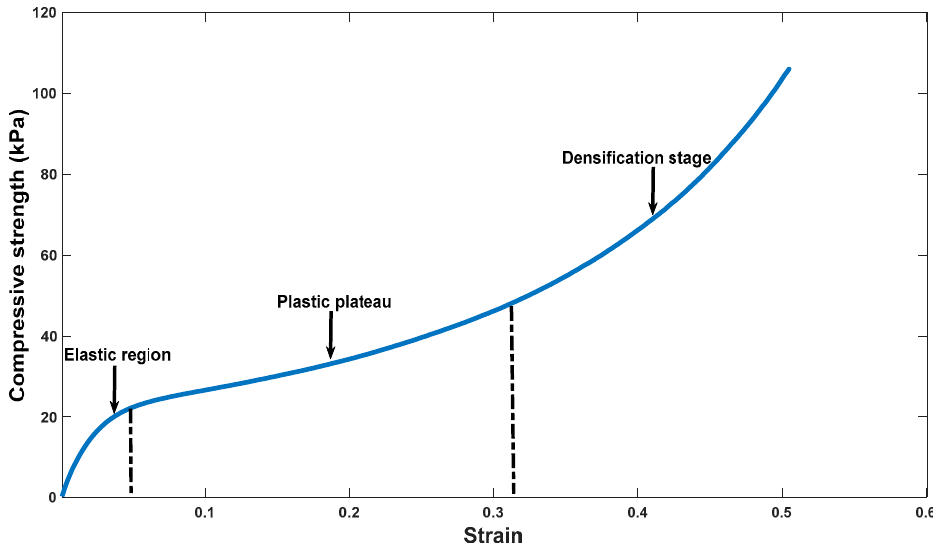
Figure 10. Example of the compressive strength-strain curve that occurs in scaffolds.